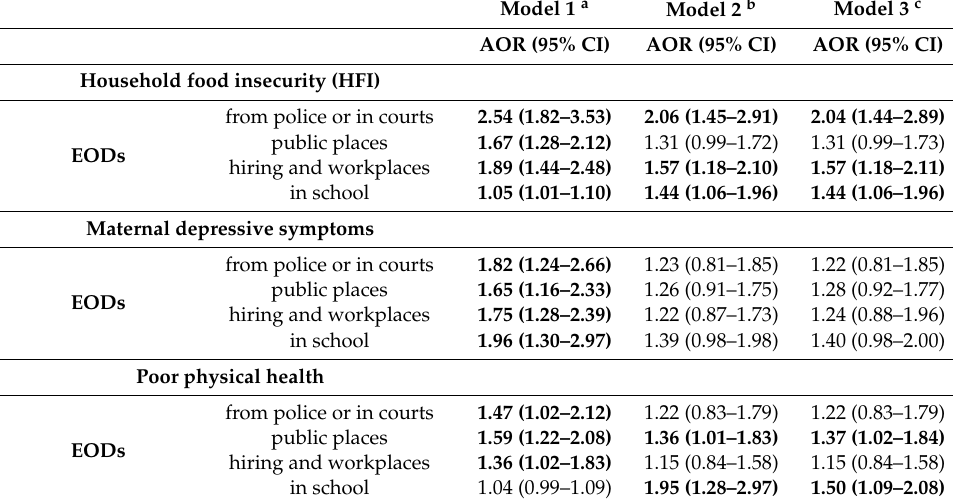
Table 3. The Association between Experiences of Discrimination (EODs), HFI and Health Outcomes (N = 1372)